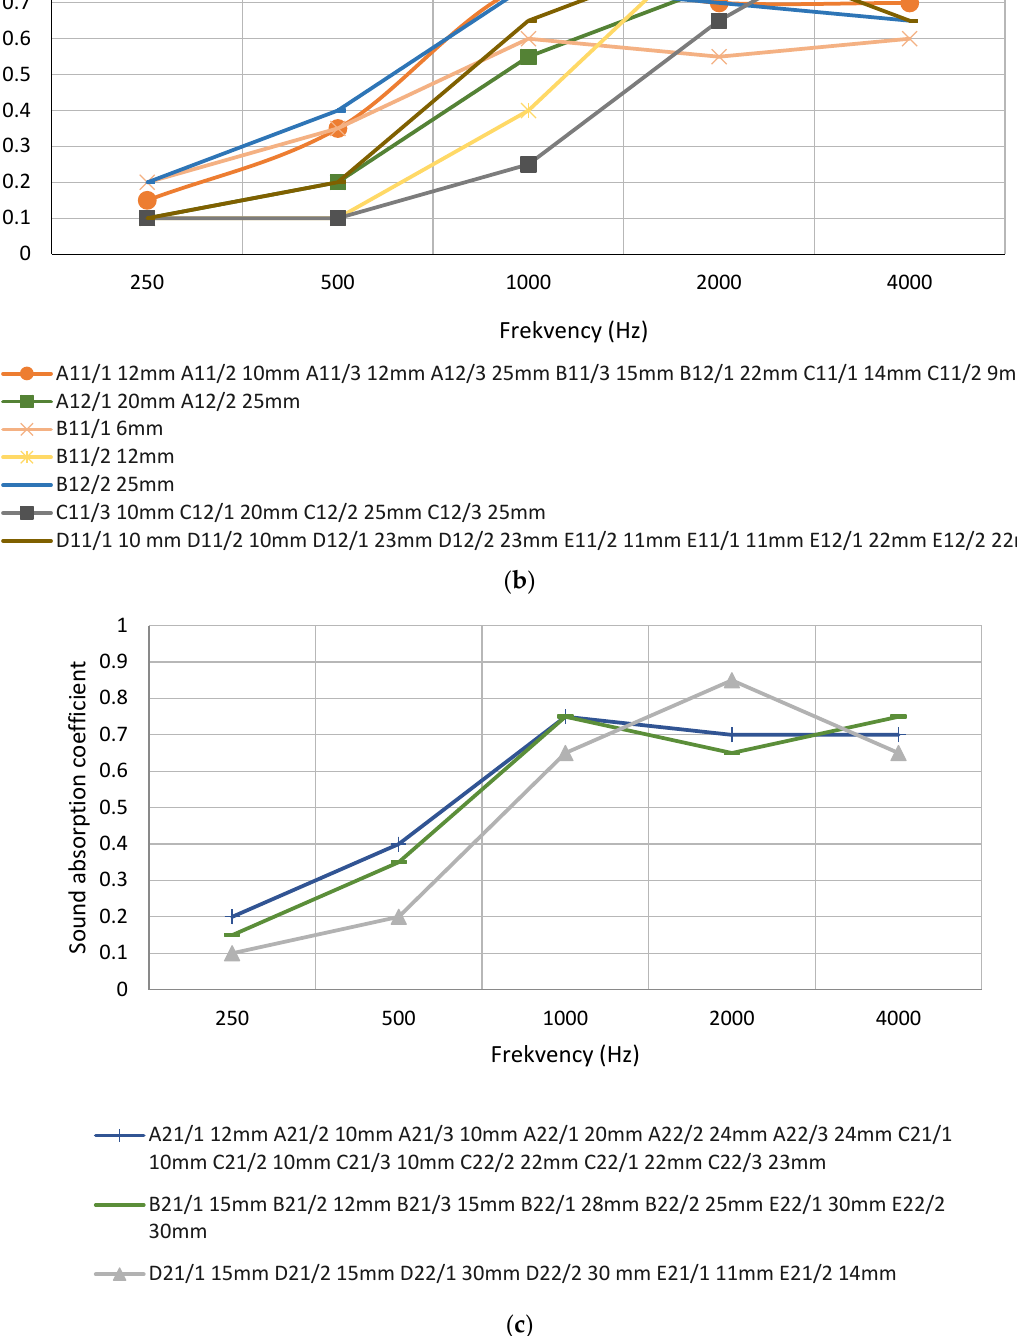
Figure 7. Sound absorption coefficient for composite materials: ( a ) Hemp composite materials; ( b ) Materials containing sapropel, moss, and flax; ( c ) Materials containing sapropel, vermiculite, and flax. A comparison of the sound absorption coefficients of the two developed material types showed that materials in which vermiculite and flax fiber were used as fillers per- formed better and more stable than materials in which moss and flax fiber were used as fillers (Figure 6).